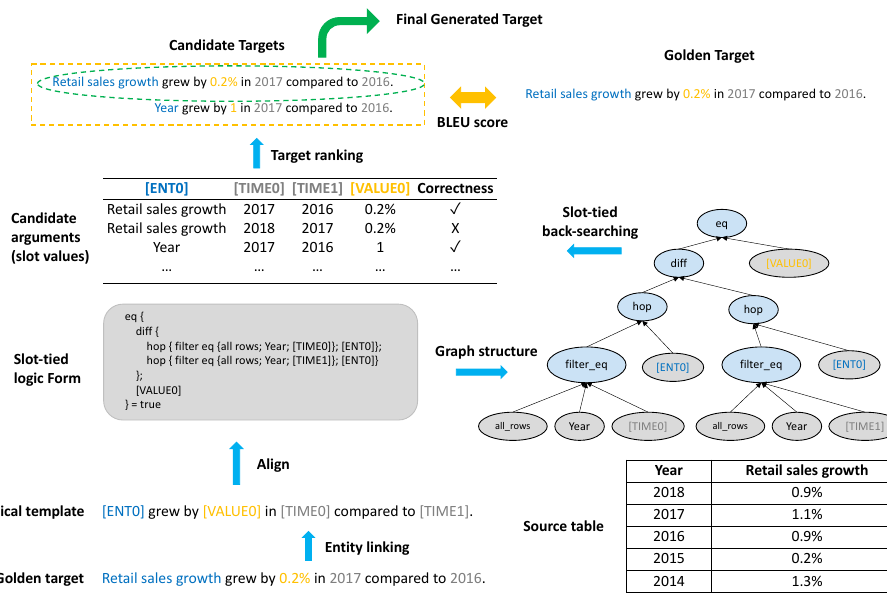
Figure 3. An overview of our SP-NLG